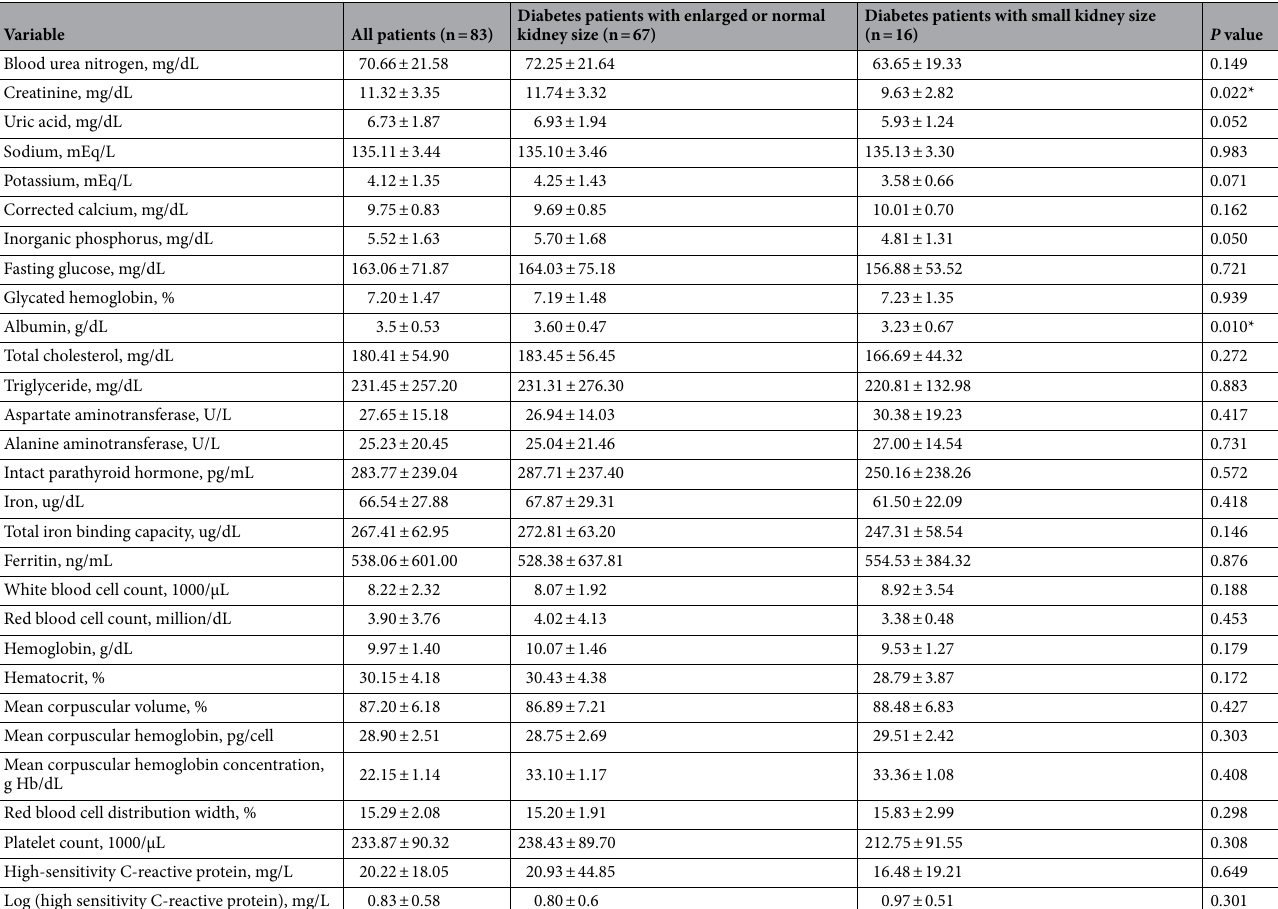
Table 2. Laboratory findings of peritoneal dialysis patients stratified by kidney size (n = 83). The data represented the last laboratory values prior to the patients being started on PD. * P < 0.05.